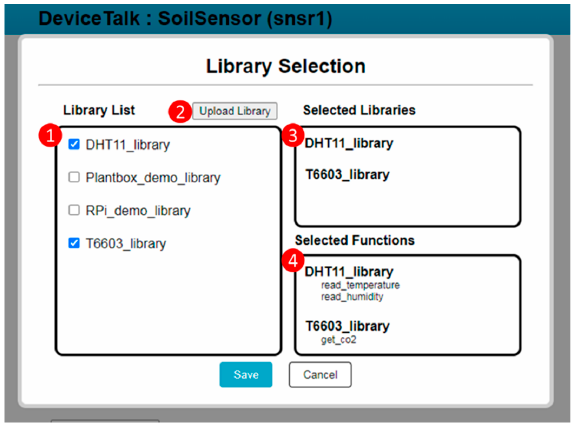
Figure 6. The library window.